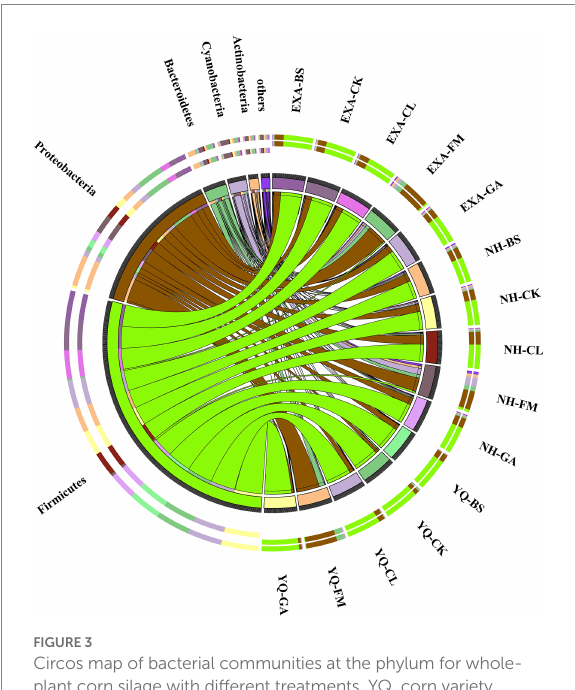
FIGURE 3 Circos map of bacterial communities at the phylum for whole- plant corn silage with different treatments. YQ, corn variety Yuqing 386; EXA, corn variety Enxiai 298; NH, corn variety Nonghe35; FM, fresh raw materials; CK, no additives; BS, 0.02% Bacillus subtilis CP7 of FM; GA, 0.2% gallic acid of FM; CL, 0.02% cellulase of